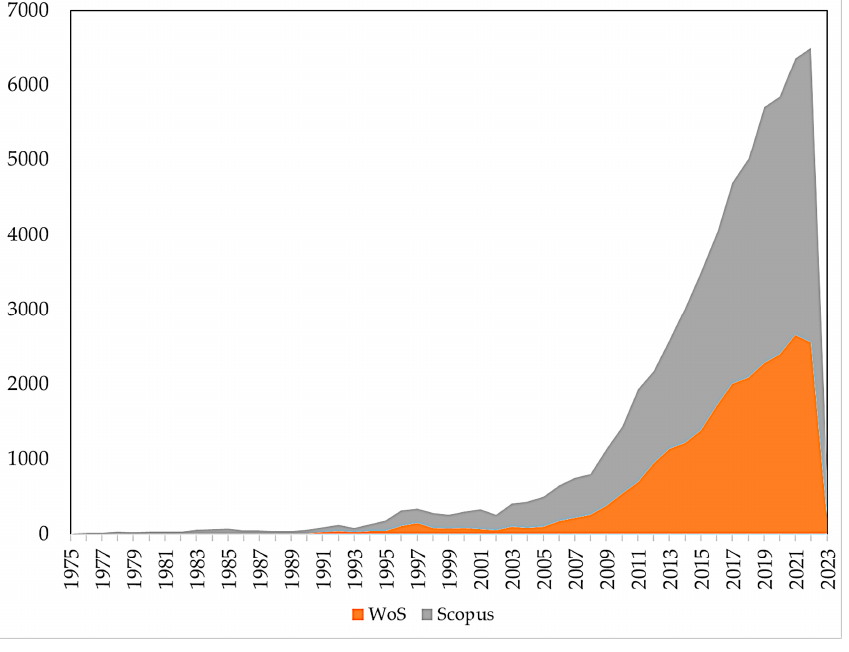
Figure 6. Number of articles published annually using second query. Source: Own elaboration. Trends regarding journals based on article count are presented in Tables 2 and 3. The results show that for the first search, most of the articles according to Web of Science are published by “Energy Policy” with 931 articles indexed in Web of Science, and as per Sco- pus, it is “Energy” with 1724 articles indexed in Scopus. In Web of Science indexation, the lowest number of articles are published in “Energy Conversion and Management” with 364 articles. Scopus has 441 articles as the lowest number published in “Renewable and Sustainable Energy Reviews”.